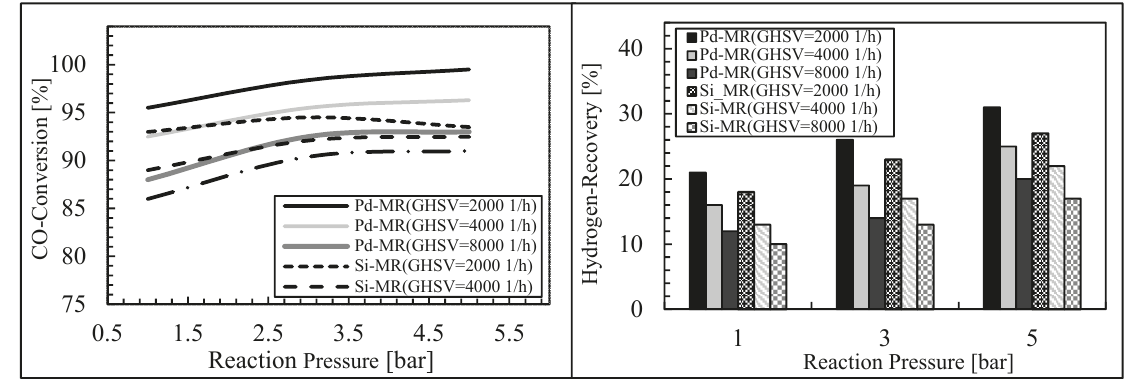
Figure 12. CO conversion and hydrogen recovery vs. reaction pressure for the dense Pd-Ag and silica MRs and TR at 623 K, H 2 O/CO = 1 and three different space velocity values. With permission to reprint from Elsevier by Ghasemzadeh et al.